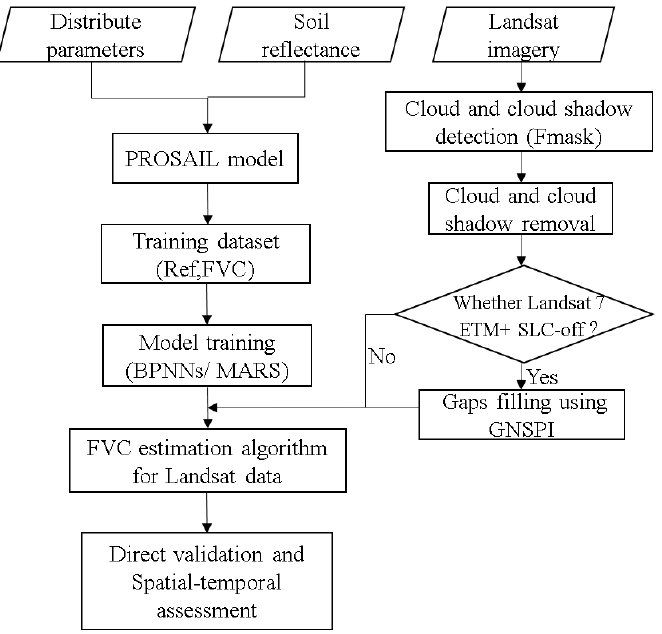
Figure 1. Flowchart of the fractional vegetation cover (FVC) estimation method for Landsat data. *PROSAIL: PROSPECT leaf optical properties model and the scattering by arbitrarily inclined leaves